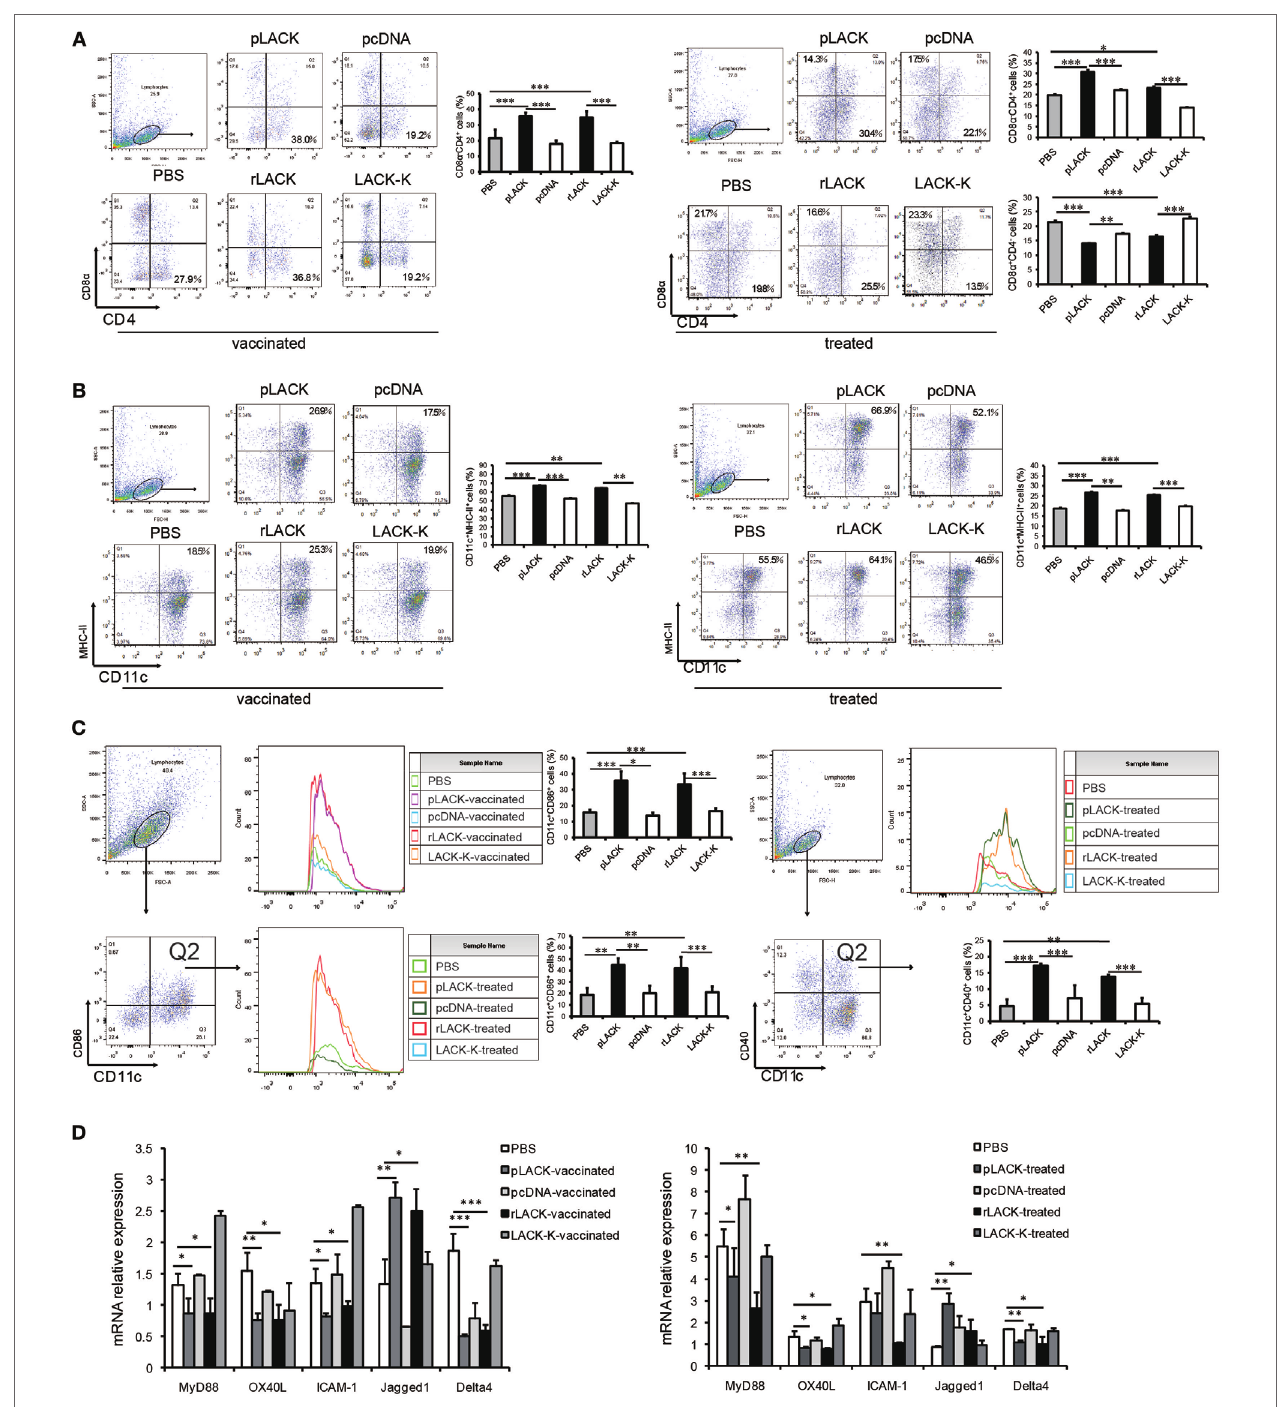
FigUre 3 | The effects of LACK 156–173 on the subsets of CD11c + dendritic cells (DCs), and their maturity and signaling pathways, in collagen antibody-induced arthritis (CAIA) mice. Single-lymphocyte suspensions from the spleens of CAIA mice were generated by mechanical disruption and red blood cell lysis 7 days after monoclonal antibody (mAb) injection. CD11c + DCs were purified from splenocytes by magnetic cell sorting. (a) The levels of the surface molecules CD8 α and CD4 on splenic DCs from LACK 156–173 epitope-vaccinated or -treated CAIA mice 7 days after injection of the mAb were quantified by flow cytometry. (B) The levels of the surface molecules CD11c and MHC class II on splenic DCs from LACK 156–173 epitope-vaccinated or -treated CAIA mice 7 days after injection of the mAb were quantified by flow cytometry. (c) The levels of the surface molecules CD11c, CD86, and CD40 on splenic DCs from LACK 156–173 epitope-vaccinated or -treated CAIA mice 7 days after injection of the mAb were quantified on FACS by double staining. (D) Co-stimulatory molecule, adhesion molecule, toll-like receptor (TLR)4 signaling pathway molecule, and Notch ligand gene expression in DCs from CAIA mice 7 days after the injection of the mAb. One representative of three independent experiments is shown. The results are expressed as the mean ± SEM. * p < 0.05, ** p < 0.01, *** p <